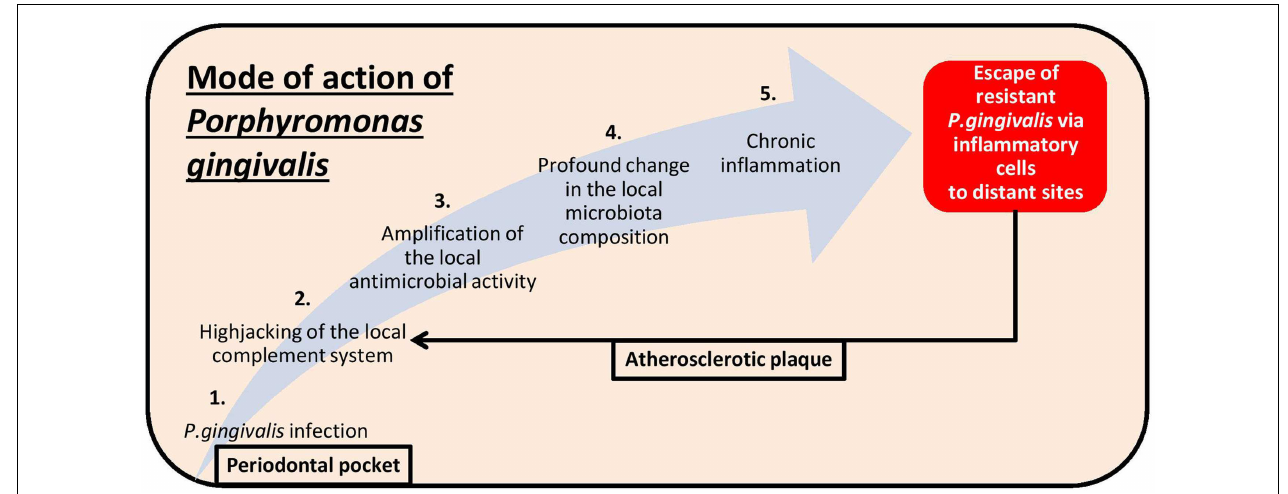
FIGURE 1 | Pathomechanistic sequence of events leading to periodontitis following Porphyromonas gingivalis infection (light blue arrow) as well as to the exacerbated pathophysiology observed in atherosclerosis plaques after evasion of the bacteria from the oral cavity (black arrow) .